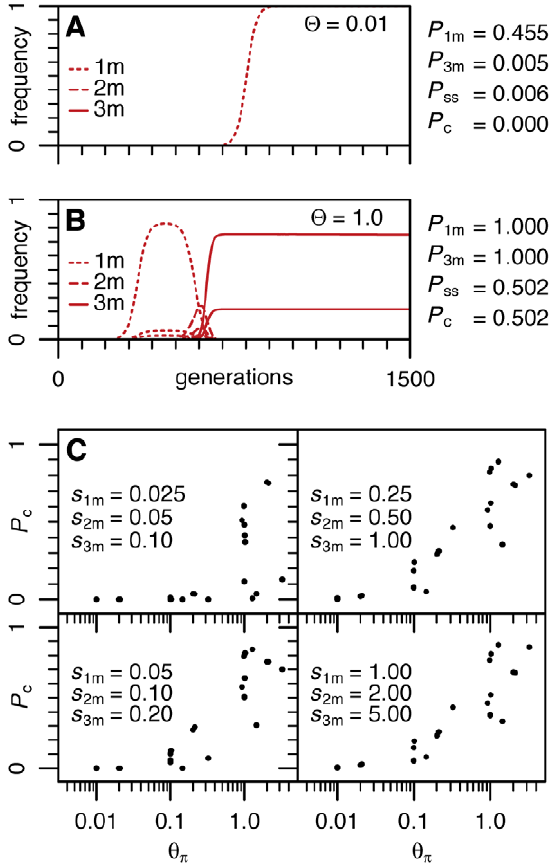
Figure 3. Population dynamics of resistance adaptation for different H regimes. (A) Frequency trajectories of resistant haplo- types from a typical simulation of a single population with H =0.01 during the first 1500 generations after pesticides are applied. The selection scenario is s 1m =0.05, s 2m =0.1, s 3m =0.2. Trajectories are shown for all resistant haplotypes that reached a population frequency above 2%. On the right, summary statistics for P 1m , P 3m , P ss , and P c estimated from 10 5 runs are shown. (B) Frequency trajectories of a typical simulation run and summary statistics for a single population with H =1. This simulation shows a soft sweep for the 3-mutation allele (two different haplotypes at high frequencies; their frequencies together add to 100%). Also, note that 2-mutation alleles do not rise to high frequencies before being taken over by the fitter 3-mutation alleles. (C) P c for a variety of different selection, recombination, and population substructure scenarios as specified in Table S3. Probabilities P c of each scenario are plotted against the average heterozygosity H p of the entire population estimated from coalescent